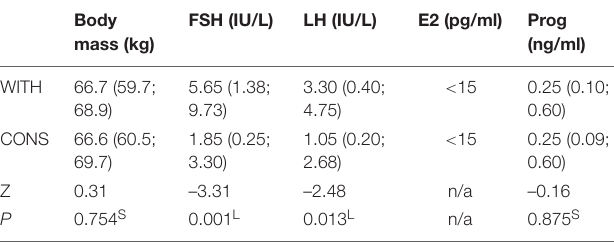
TABLE 3 | Descriptive data of body mass and blood parameters comparing OCP withdrawal and consumption ( n =